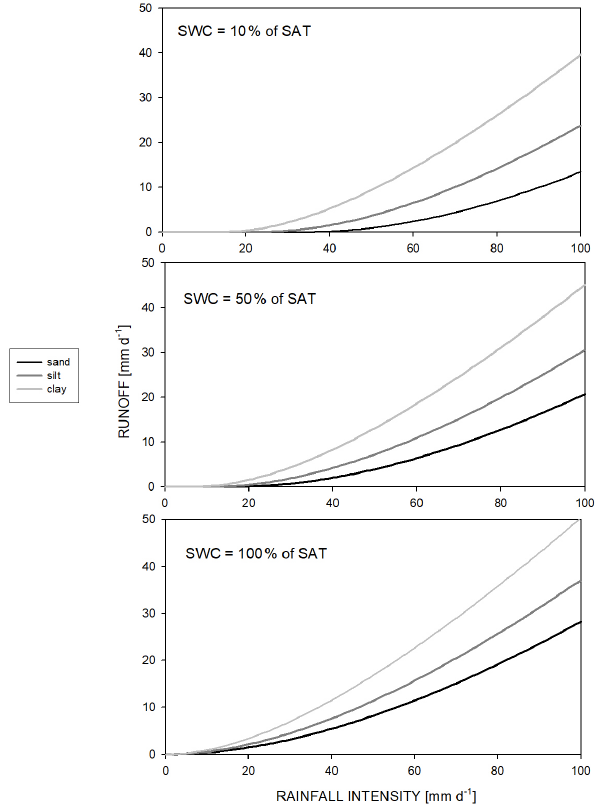
Figure 1. Hortonian runoff as a function of rainfall intensity, soil type, and actual soil water content of the topsoil layer. Sand soil means 92% sand, 4% silt, and 4% clay; silt soil means 8% sand, 86% silt, and 6% clay; clay soil means 20% sand, 20% silt, and 60% clay. SWC and SAT denote soil water content and saturation,